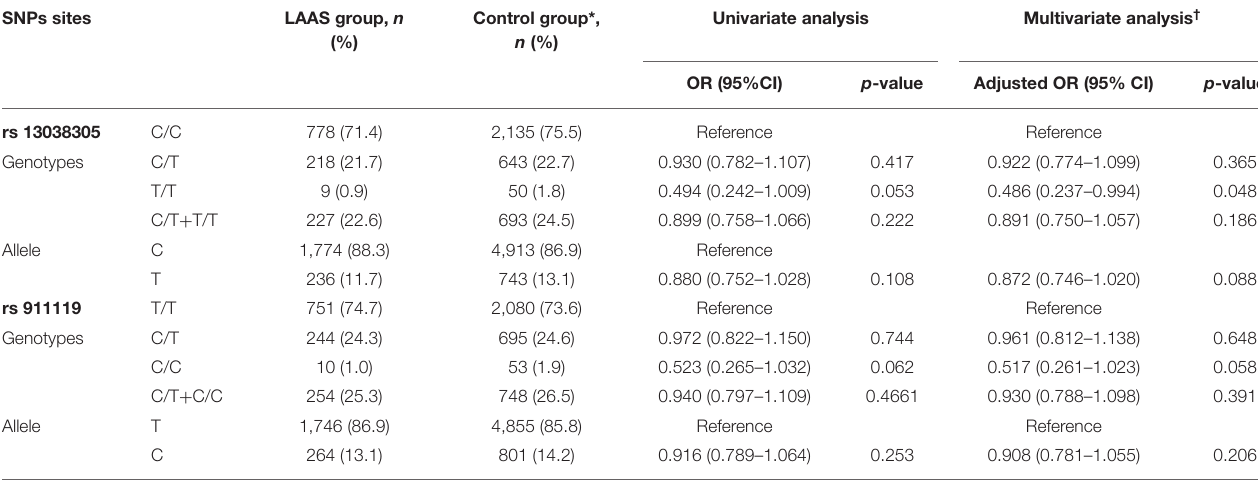
TABLE 2 | Genotype and allelic frequencies of CST3 SNPs in LAAS and control subjects. SNPs sites